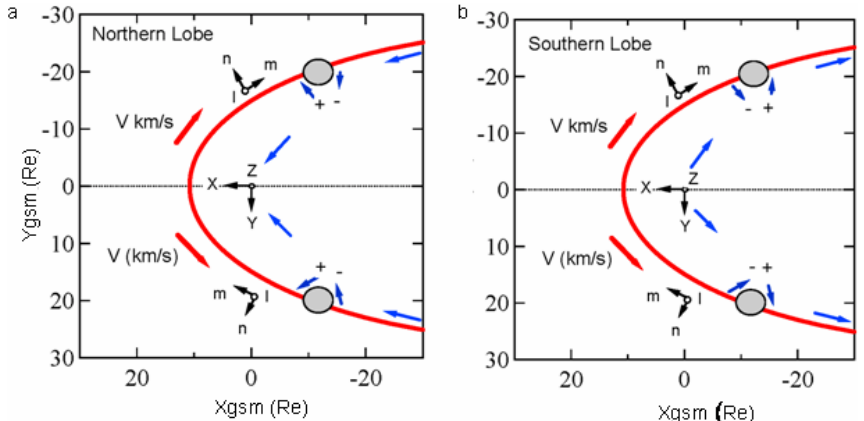
Fig. 3. Polarities of lobe FTEs in the Northern and Southern Hemispheres, respectively. Red arrows show direction of antisunward motion of plasma in the magnetosheath. Blue arrows indicate direction of the Earth’s magnetic field that in the northern (southern) lobe is directed sunward (antisunward). The antisunward moving events generate direct ( + , − ) signatures in the southern lobe and reverse ( − , + ) signatures in the northern